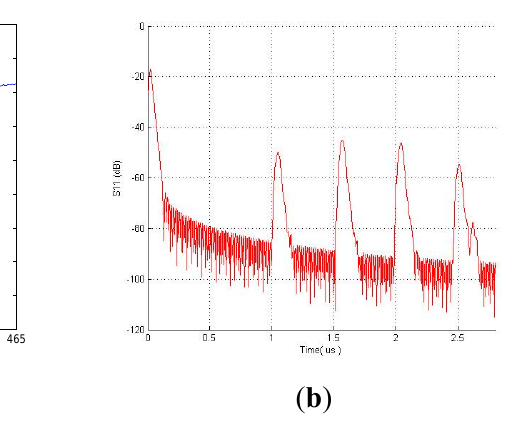
Figure 3. Coupling of mode (COM) modeling results for reflection coefficient S 11 of one port SAW reflective delay line by using bidirectional IDTs and four shorted grating reflectors in ( a ) frequency domain and ( b ) time domain.